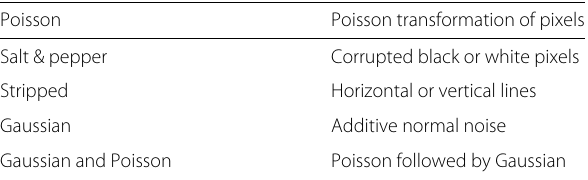
Table 1 Description of Poisson noise, salt & pepper noise, stripped noise, Gaussian noise, and Gaussian and Poisson noise Poisson Poisson transformation of pixels Salt & pepper Corrupted black or white pixels Stripped Horizontal or vertical lines Gaussian Additive normal noise Gaussian and Poisson Poisson followed by